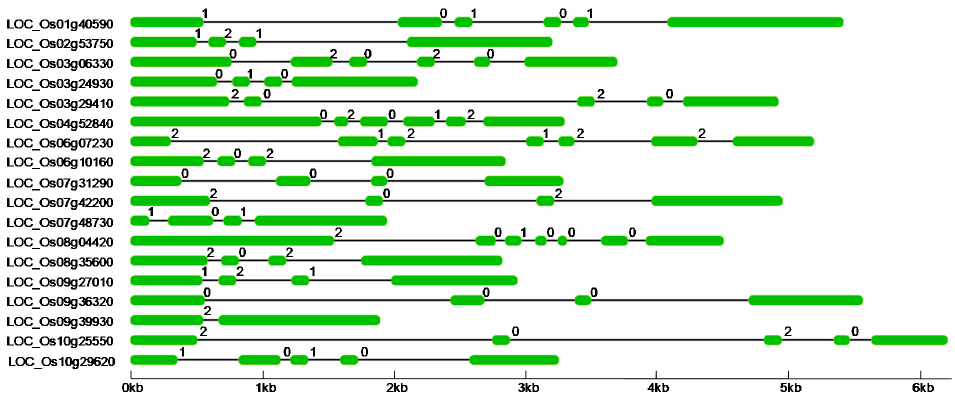
Figure 3. Gene structure of PTKs genes in rice. Coding sequence (CDS) is shown as green color box, intron as Block line and 0, 1, 2 on the introns depics intron